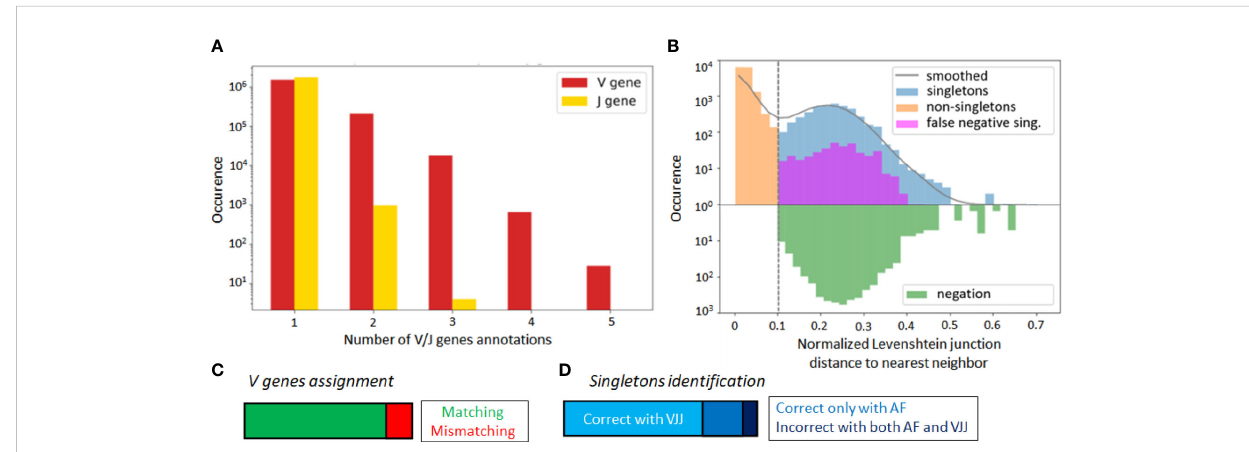
FIGURE 3 (A) Occurrence rate of B-cell sequence with multiple V and J gene segment annotations of equivalent alignment score after the IgBlast query in the GC dataset. (B) Distance to nearest distribution for B-cell sequences in the alignment-based (VJ& Junction method) clonal identi fi cation method in the GC dataset. False negative singletons originating from V or J gene misalignment are depicted in purple. (C) Proportion of matched and mismatched V gene assignment between the original and truncated simulated dataset (where the fi rst 70 nucleotides were arti fi cially removed). (D) Correctly and wrongly assigned singletons by the VJJ and AF method on the simulated